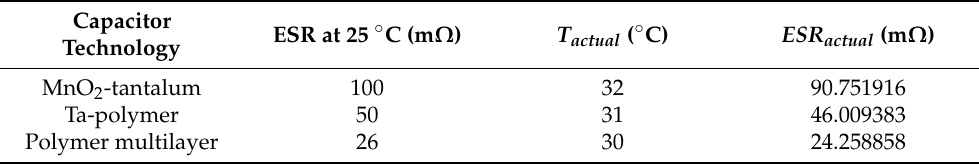
Table 5. Actual ESR in working environment within mission profile.